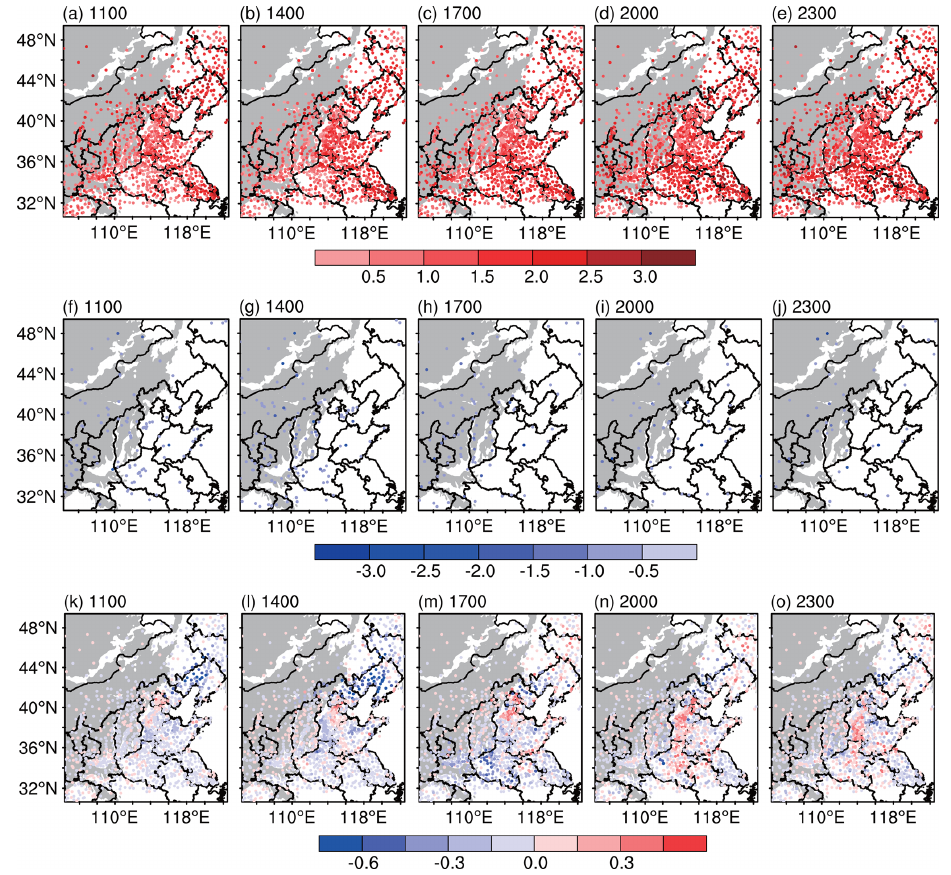
Figure 16. The bias of 10m wind speed (ms − 1 ) at 11:00, 14:00, 17:00, 20:00 and 23:00LT for (a–e) overestimated sites and (f–j) underes- timated sites in NoAero averaged during 6 to 10 December 2015. (k–o) The difference of absolute value of bias (ms − 1 ) between Aero and NoAero (Aero minus NoAero). The gray areas denote the areas of terrain height above 1000m.